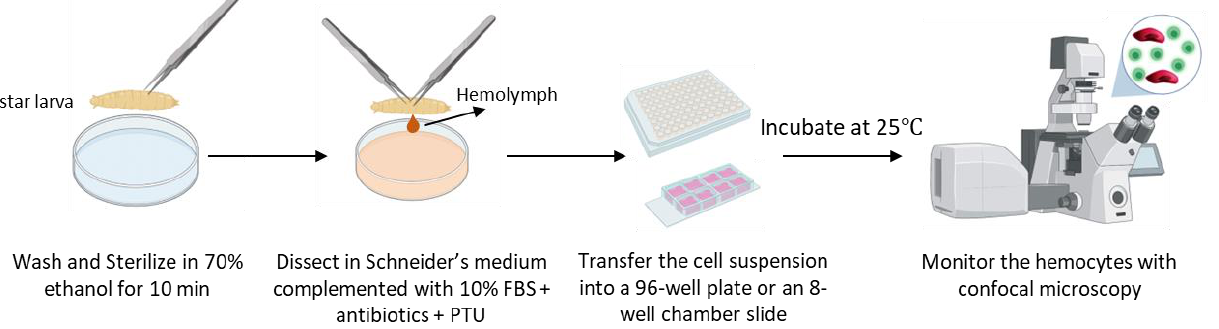
Figure 1. A schematic illustration of the Drosophila hemocyte culturing method.